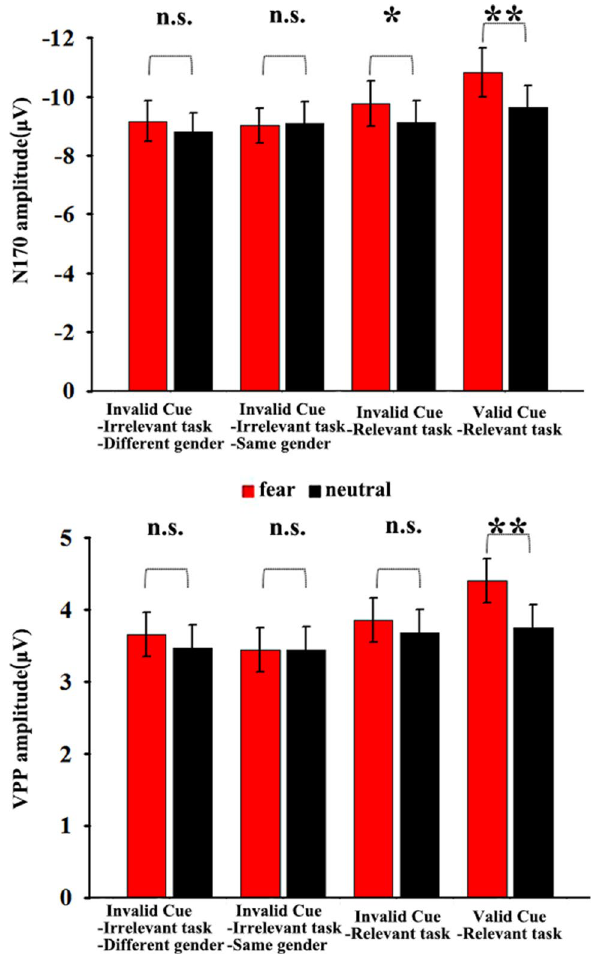
Figure 4. A bar plot reporting the results in the N170 and VPP components in the different top-down controls; * P < 0.05, ** P <